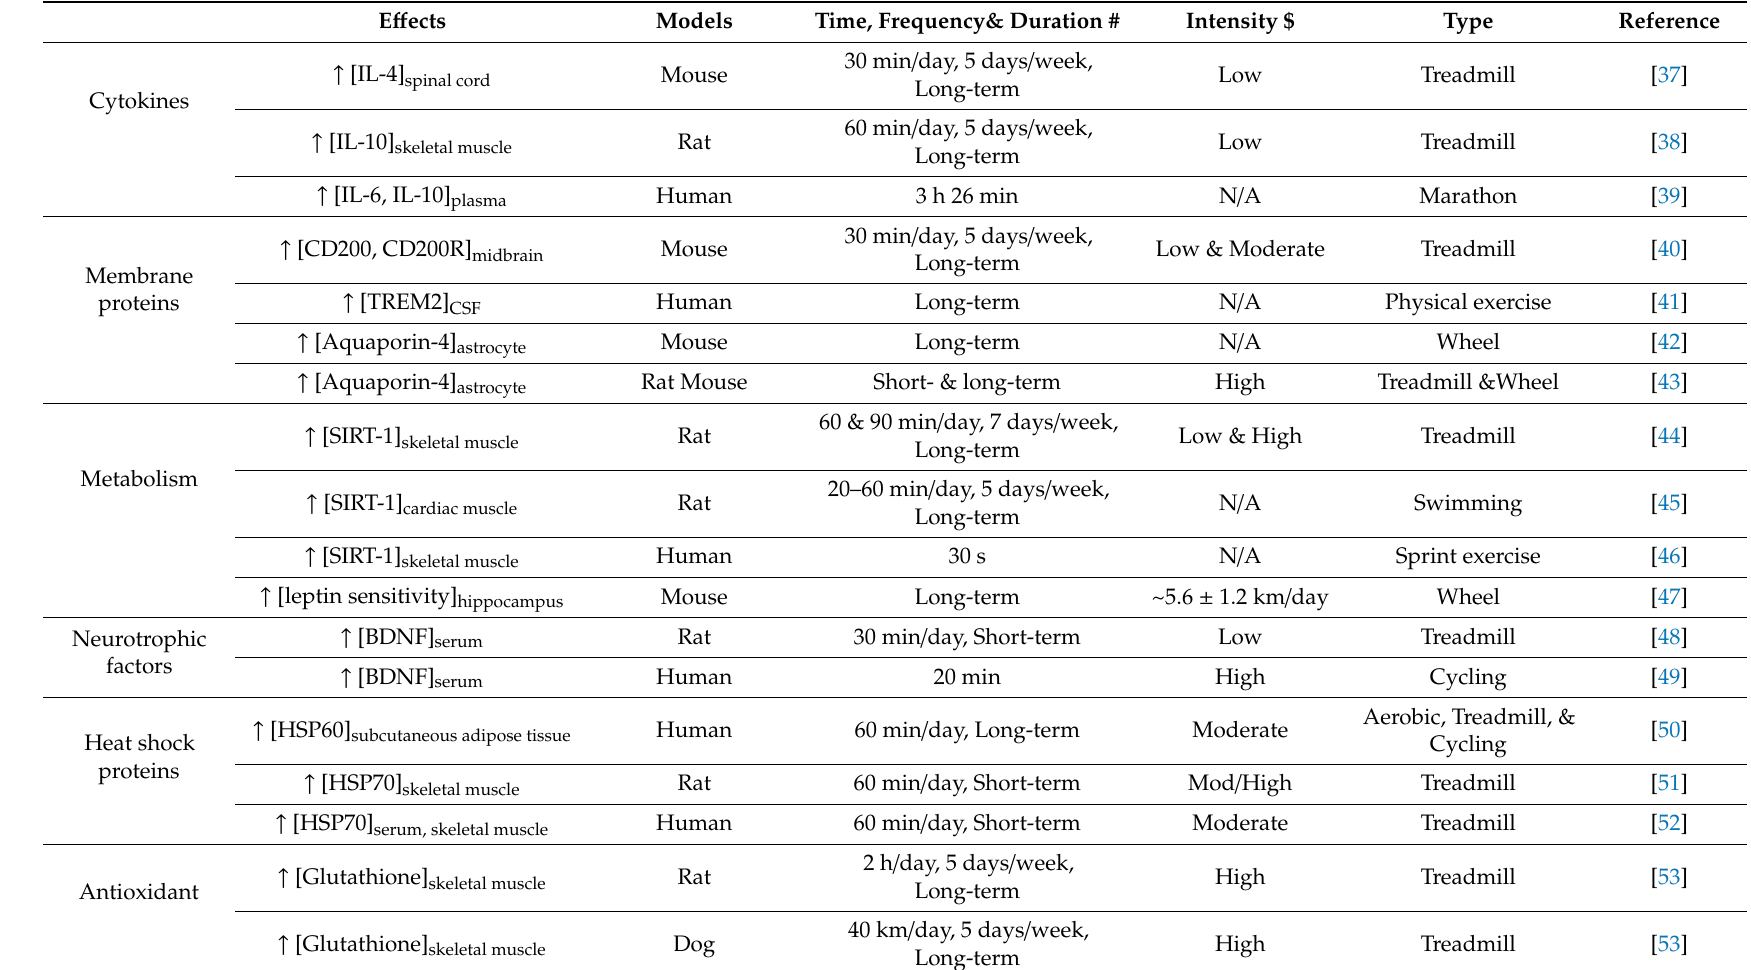
Table 1. Exercise regulates microglial activation by increasing anti-inflammatory